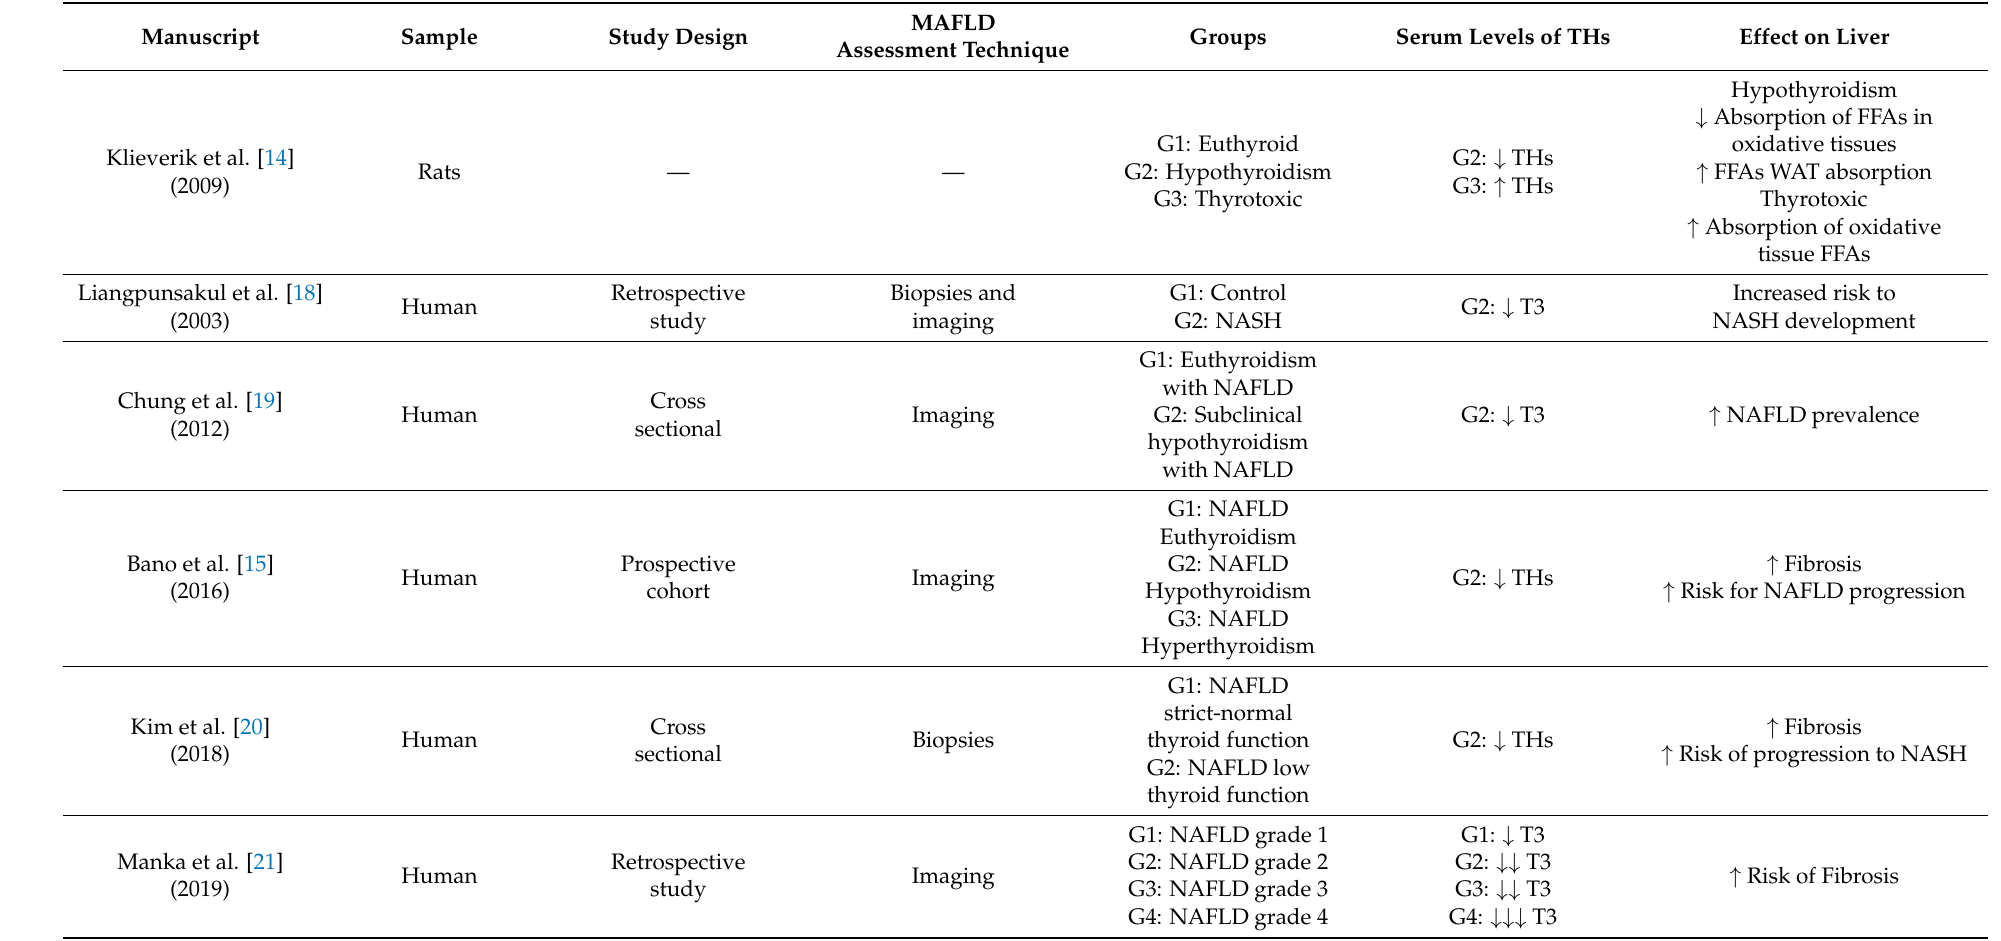
Table 1. Changes in thyroid hormones and their effects on the